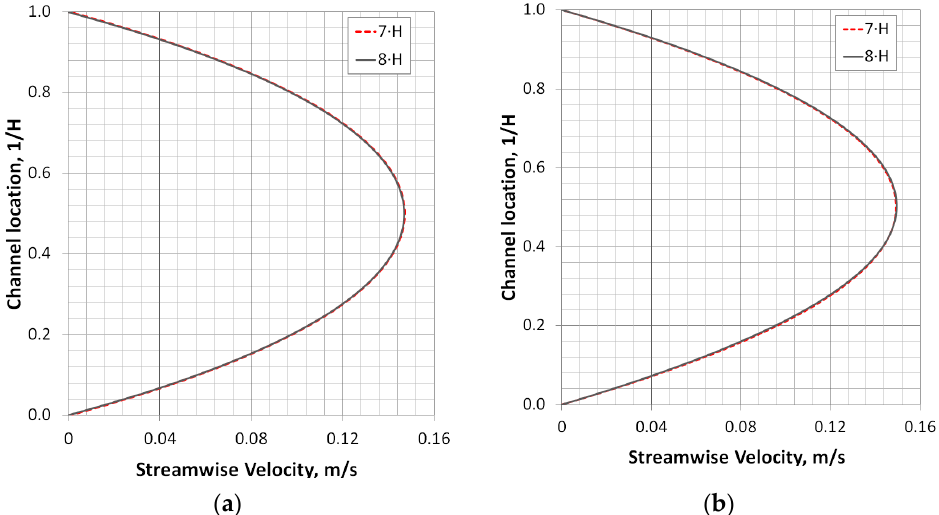
Figure A1. Streamwise velocity upstream of the corner bend: ( a ) elastic vortex for Wi = 1.0, El = 100, β = 0.1; ( b ) inertial vortex for Re = 100.